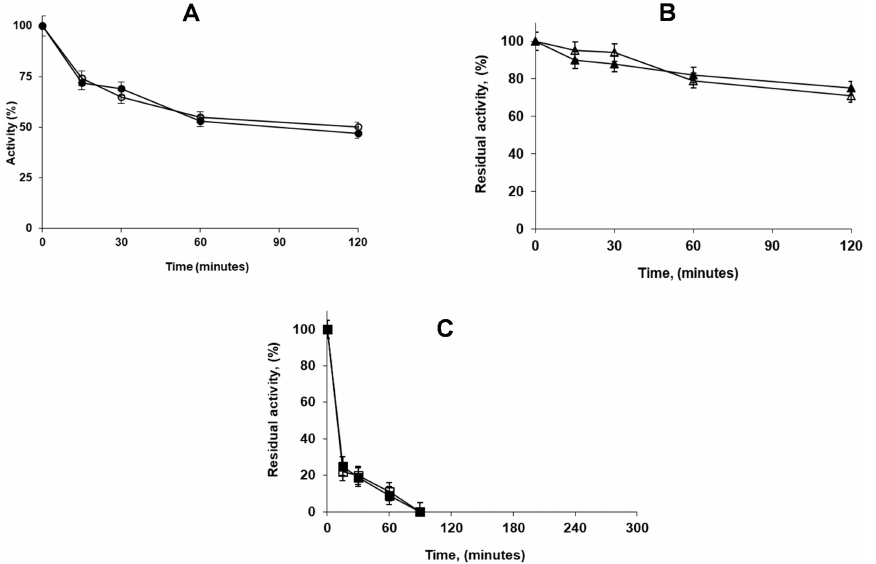
Figure 6. E ff ect of incubation in the presence of 4% Triton X-100 of the supports and washing as described in methods on the stability of glyoxyl-octyl-PFL at 70 ◦ C, pH 7 ( A ). Reduced glyoxyl-octyl was submitted to the same protocols, and then RML ( B ) or LU ( C ) were immobilized. Inactivation was performed at 55 ◦ C and pH 7. Experiments were performed as described in Methods. Empty symbols: enzyme immobilized in supports without incubation with Triton X-100 (control); solid symbols: enzyme immobilized on support incubated in Triton X-100 and washed with distilled water as described in